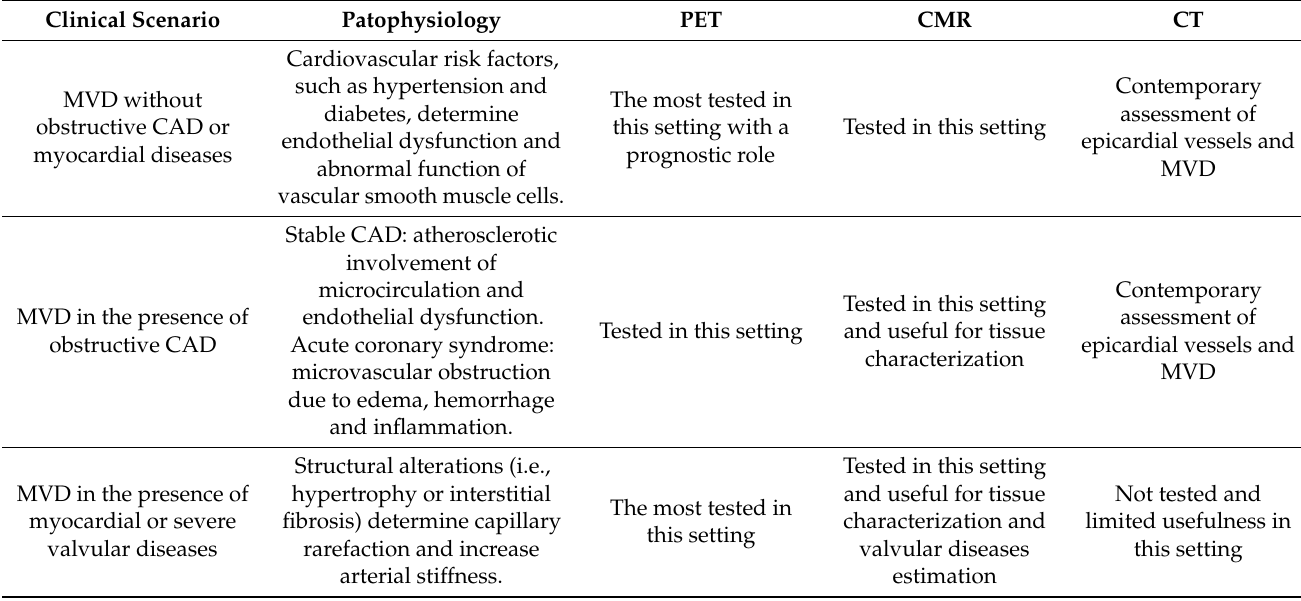
Table 1. Three clinical scenarios of MVD and the suggested assessment modalities.